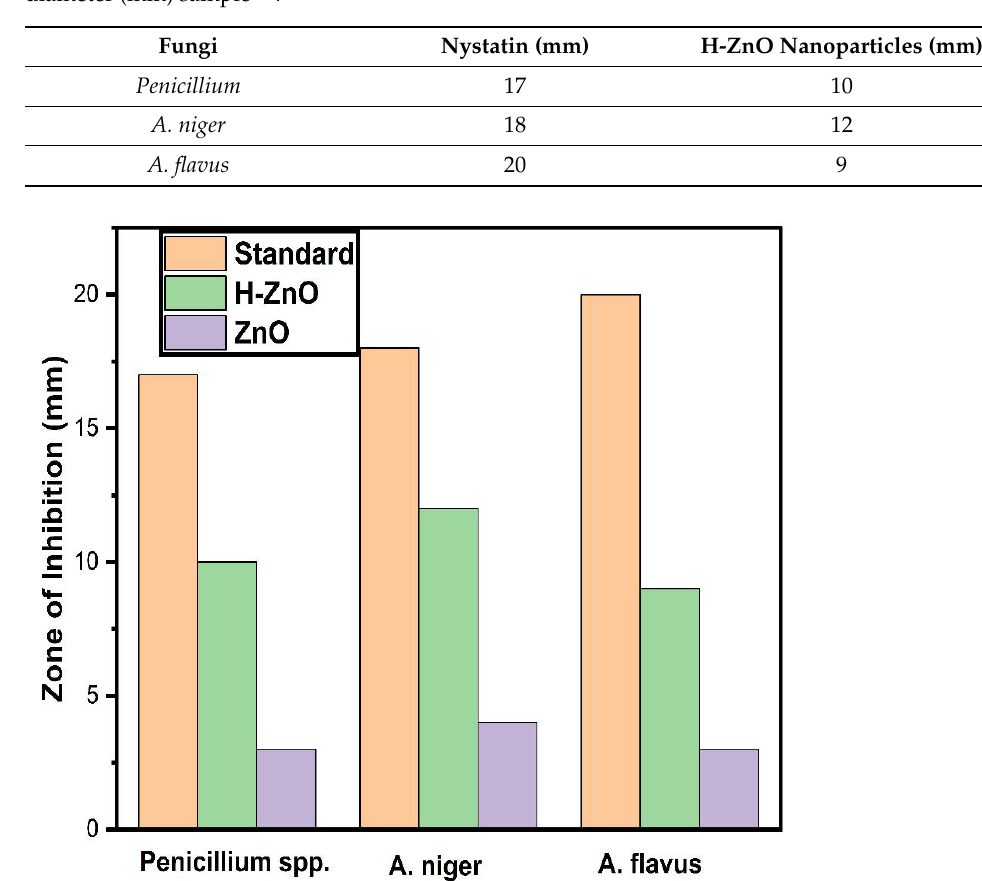
Table 2. Antifungal activity of H-ZnO nanoparticles on fungal species reported as zone of inhibition diameter (mm) sample − 1 .